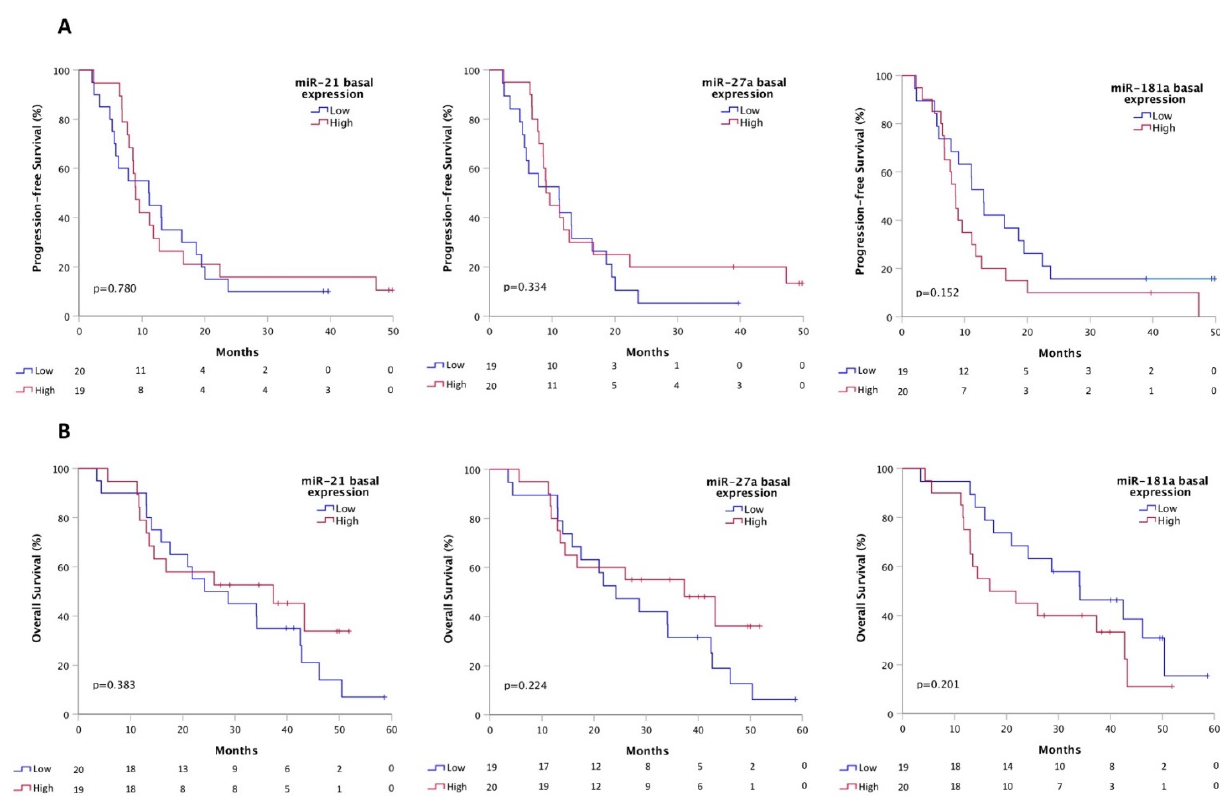
Figure 1. Kaplan–Meier curves for basal miRNA expression and correlation with PFS ( A ) and OS ( B ). Basal differential expression of the candidate miRNAs was evaluated on the basis of the best objective response to EGFR-TKI treatment. When patients were stratified accord- ing to their best response (partial response/complete response [PR/CR] vs. stable dis- ease/progression of disease [SD/PD]), patients who achieved PR/CR as their best response had a significantly higher basal value of miR-21 than patients who achieved SD/PD ( p = 0.011) (Figure 2A). Dividing the patients according to the duration of clinical benefit ( ≥ 6 months vs. <6 months), patients who achieved a clinical benefit ≥ 6 months had a higher basal value of miR-21 than patients with clinical benefit <6 months ( p = 0.039) (Figure 2B).